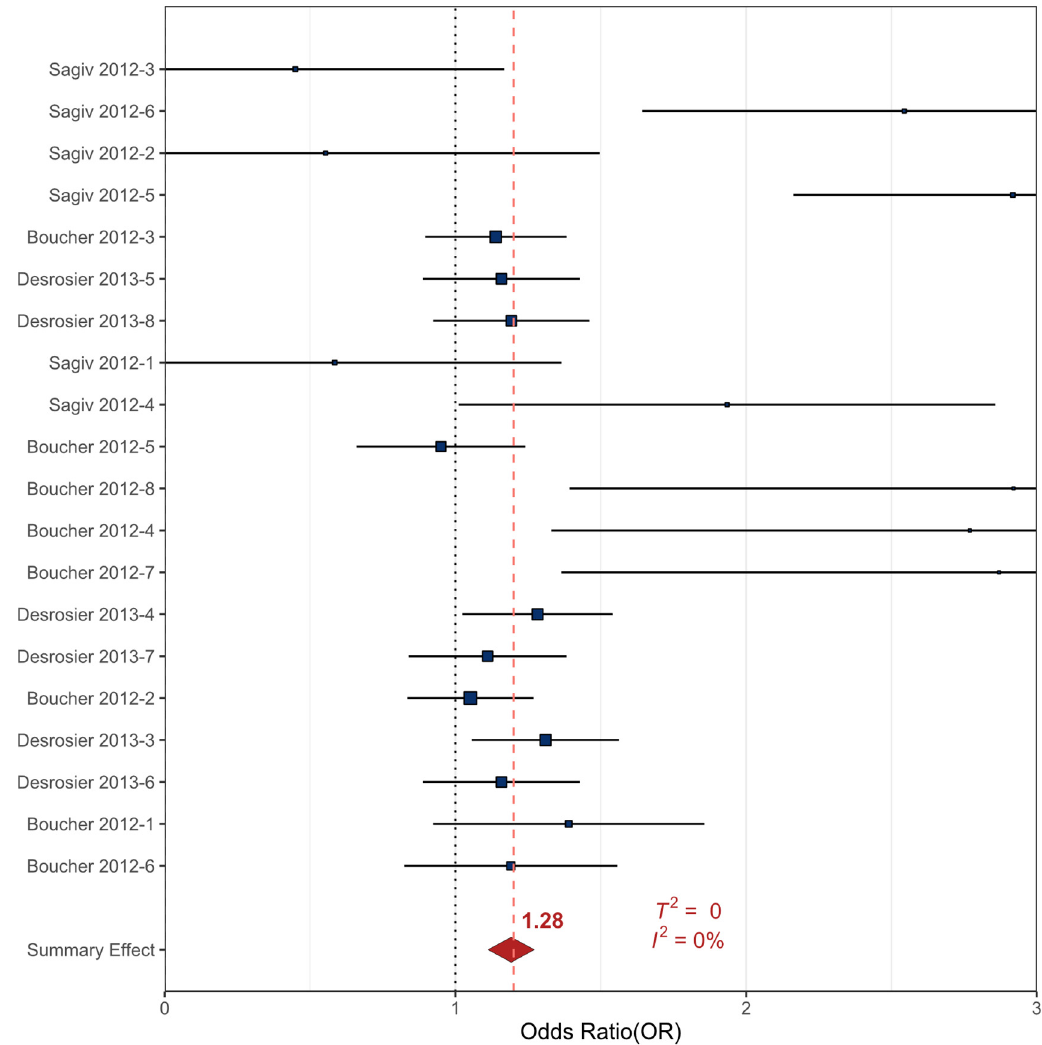
Figure 6. Forest plot showing the random effects meta-analysis for prenatal exposure to Hg and all externalizing behavioral health outcomes. The squares represent the mean OR from each reference datum (Table S6), horizontal error bars represent the upper and lower 90% CI, the size variation of the boxes represent the weight each dataset had in the meta-analysis with a larger size indicating larger weights. The diamond and dashed line represent the summary effect OR based on the meta-analysis. The ‘line of no effect’ at an OR of 1 is indicated with a dotted line.